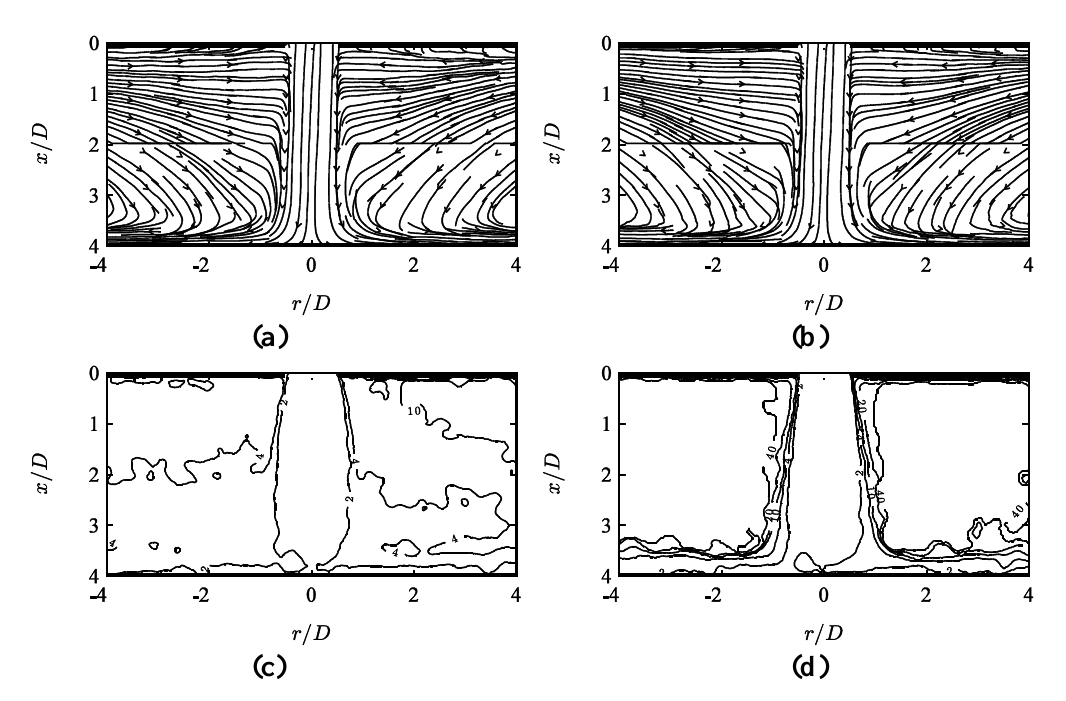
= 0.02 px and p = 5 (in Equation (8)) and s = {1, 2, 4, 10, 20, 40, min